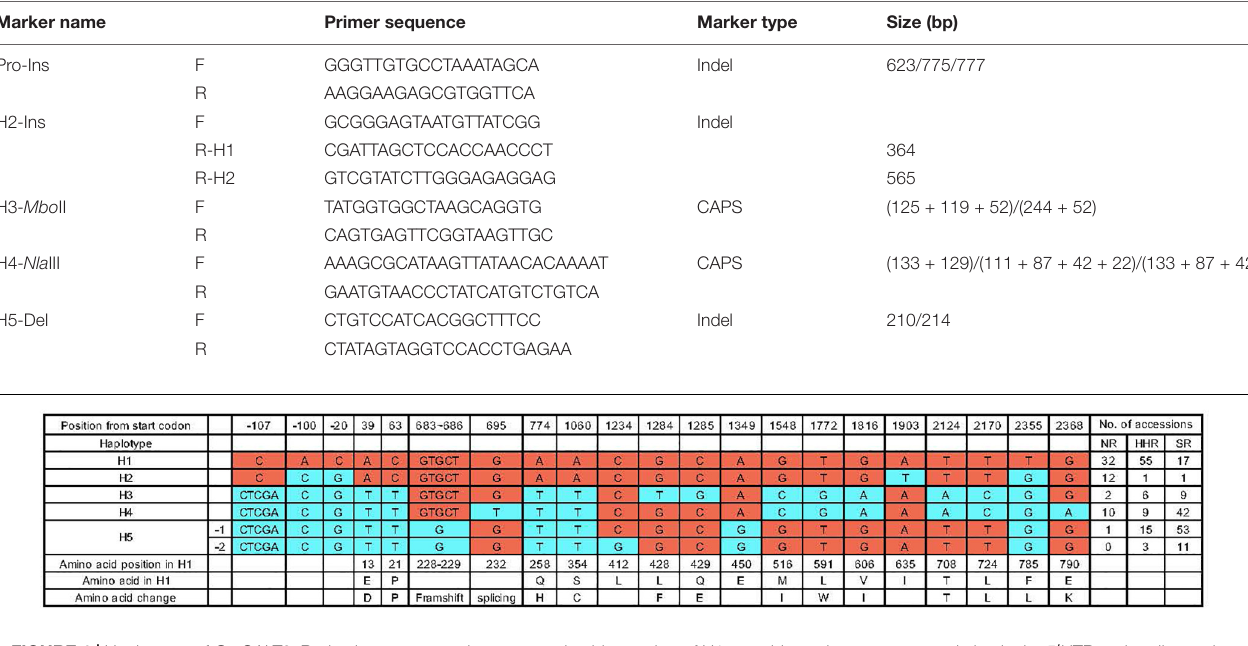
FIGURE 1 | Haplotypes of GmSALT3 . Red color represents the same nucleotides as that of H1 type, blue color represents variation in the 5 (cid:48) UTR and coding regions different from that of H1 type. See Supplementary Table 2 for the whole genomic variation of GmSALT3